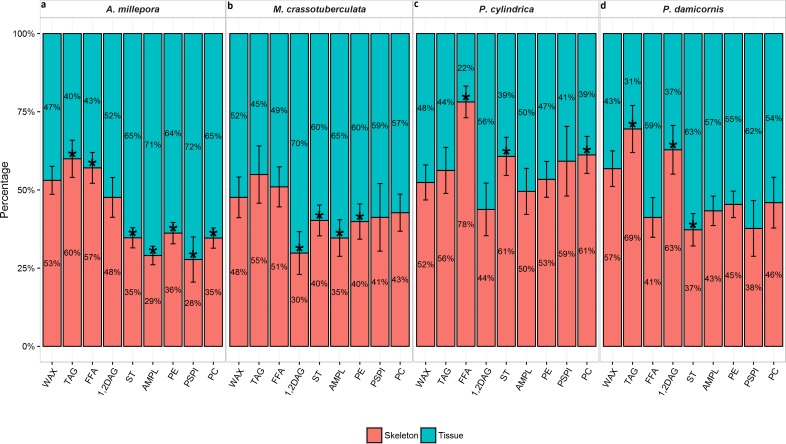
Lipid class composition of denuded skeleton and isolated tissue of four scleractinian species prepared with the air-spraying method—relative contribution (% total) Values are presented as means ± SEM (n = 20).* denote significant differences between stacked bars within each species (tissue vs skeleton) (P < 0.05).